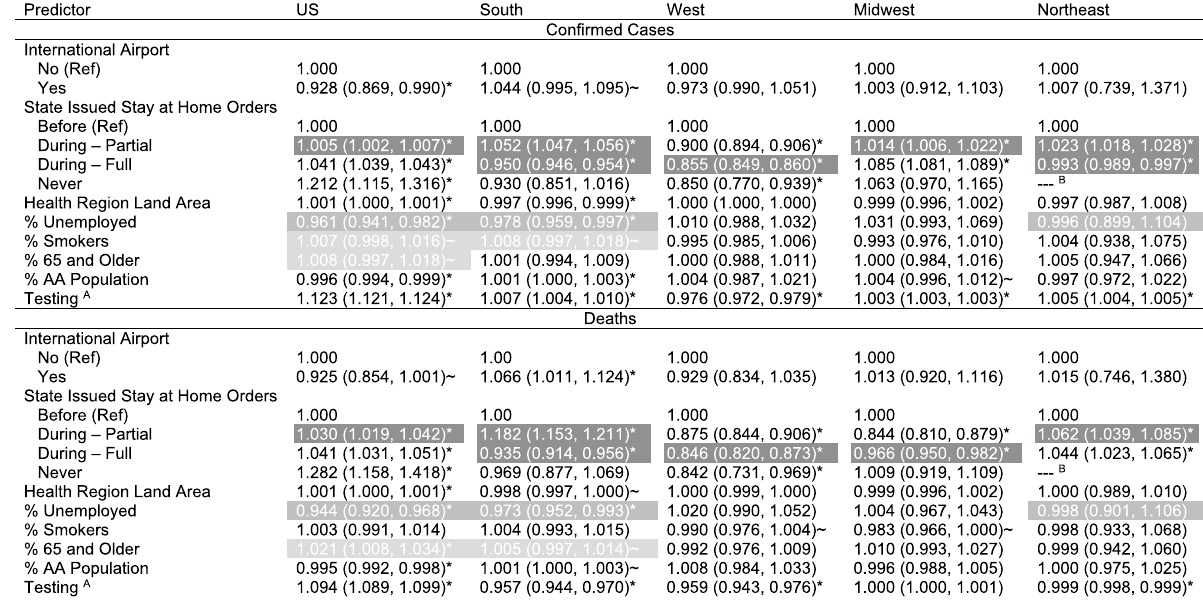
Table 1. Fixed effect parameter estimates for the confirmed cases and deaths outcomes represented as inverse logarithm mean estimates and associated 95% credible intervals. A Percent of positive tests was used for the Midwest and Northeast while log count of positive tests was used for all other models. B There is no estimate associated with the never category of the stay at home orders variable for the NE model because all states in the Northeast issued a stay at home orders. *Indicates well estimated Bayesian inference at the 0.05 level. ~ Indicates borderline Bayesian inference. Gray highlights indicate common estimate patterns mentioned in the text. Figure 2 displays the spatial and temporal random effect estimates for confirmed cases across the United States. These visuals display the residual spatial and temporal variation in the outcome after adjusting for the fixed effects in this table. Hence, increased (estimates greater than 1) or decreased (estimates less than 1) risk could arise from reasons pertaining to social distancing adherence or alternate population characteristics not considered in this study. In the spatial random effect, state borders are largely well defined here indicating consistency in the residual within states. After adjustment, many of the health regions with increased risk include parts of Idaho, Louisiana, Montana, and Alaska, Texas, Oklahoma, Arkansas, West Virginia, Virginia, Maryland, Delaware, and Hawaii. Alternatively, areas of decreased risk include parts of Louisiana and Mississippi, California, Florida, and New York. Finally, the temporal random effect parameter largely accounts for delays and errors in the data 11 . There are three sharp peaks at days 19 (April 10), 31 (April 22), and 55